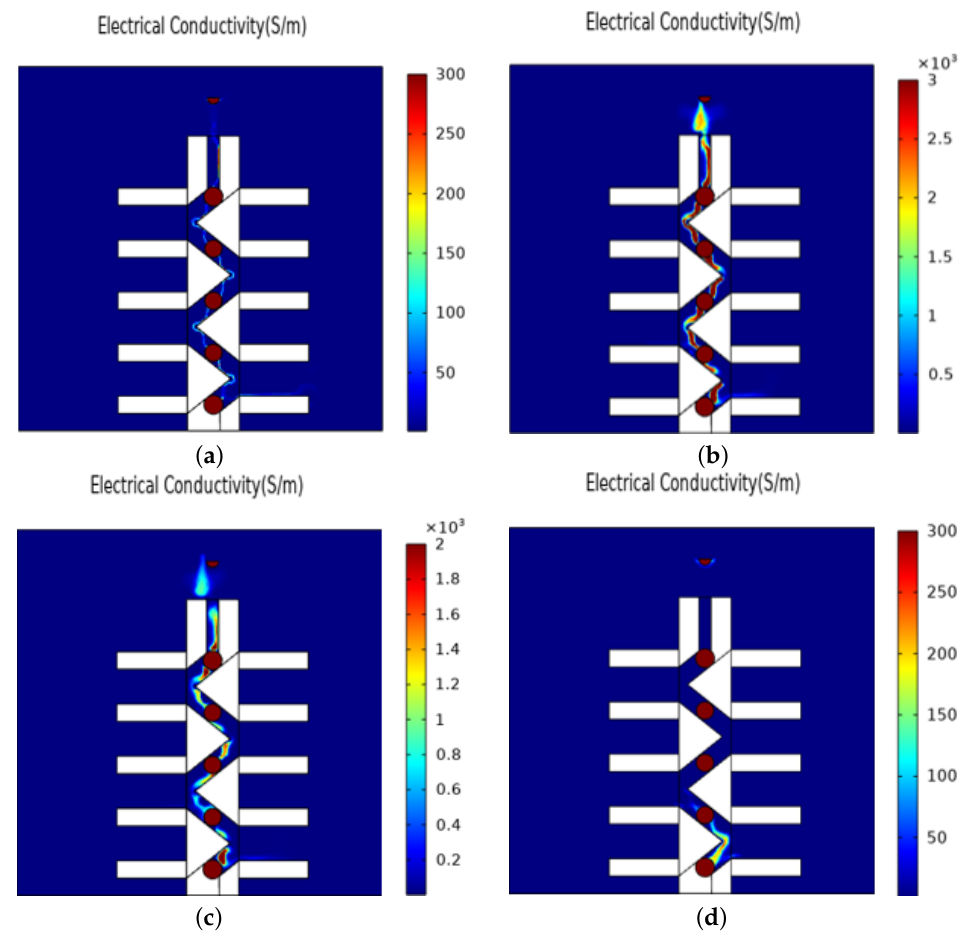
Figure 8. Arc conductivity change diagram in the simulation area at different moments: ( a ) t = 10 µ s;